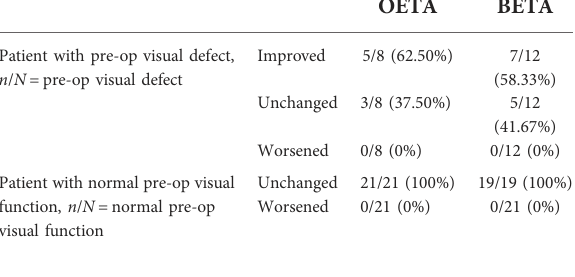
TABLE 3 Post-op visual outcomes.